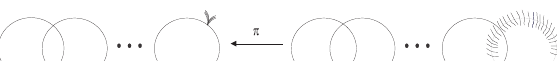
Figure 1 - Blowing-up infinitely many